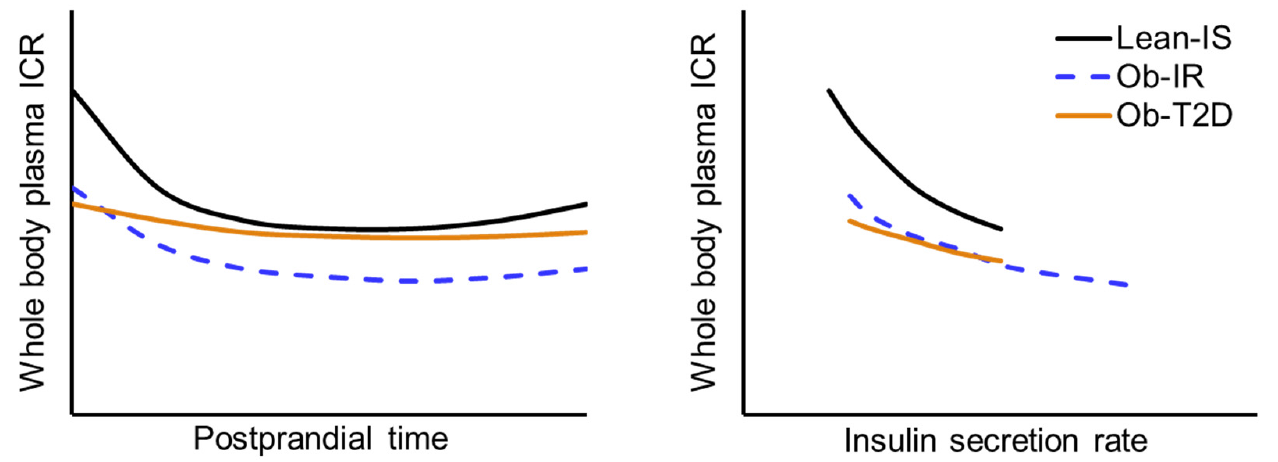
Figure 5. Effect of obesity, insulin resistance, and type 2 diabetes on basal and postprandial plasma insulin clearance rate. Left panel: Whole-body plasma insulin clearance rate during basal conditions and for three hours after glucose ingestion. Right panel: Plasma insulin clearance rate in relationship to insulin delivery to tissues during basal conditions and during the early postprandial period. Adapted from references [3,8,83]. Abbreviations: ICR, insulin clearance rate; IS, insulin sensitive; IR, insulin resistant; Ob, obese; T2D, type 2 diabetes.